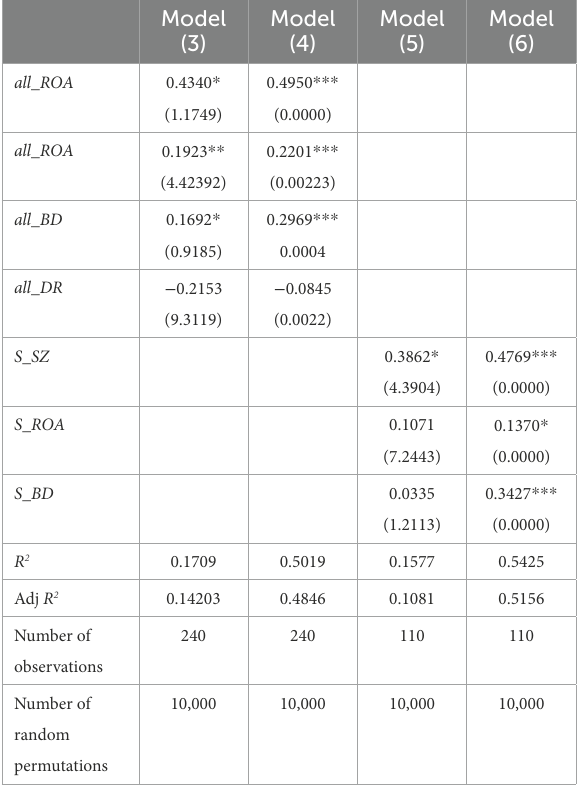
TABLE 3 Model regression test and robustness test